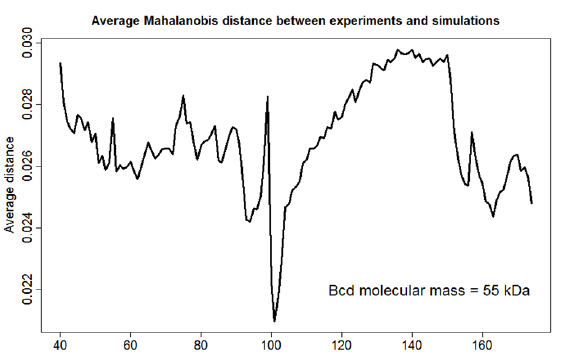
Figure 10: Time behavior of average Mahalanobis distance between experimental and simulated spatio-temporal dynamics of Bicoid protein gradient.